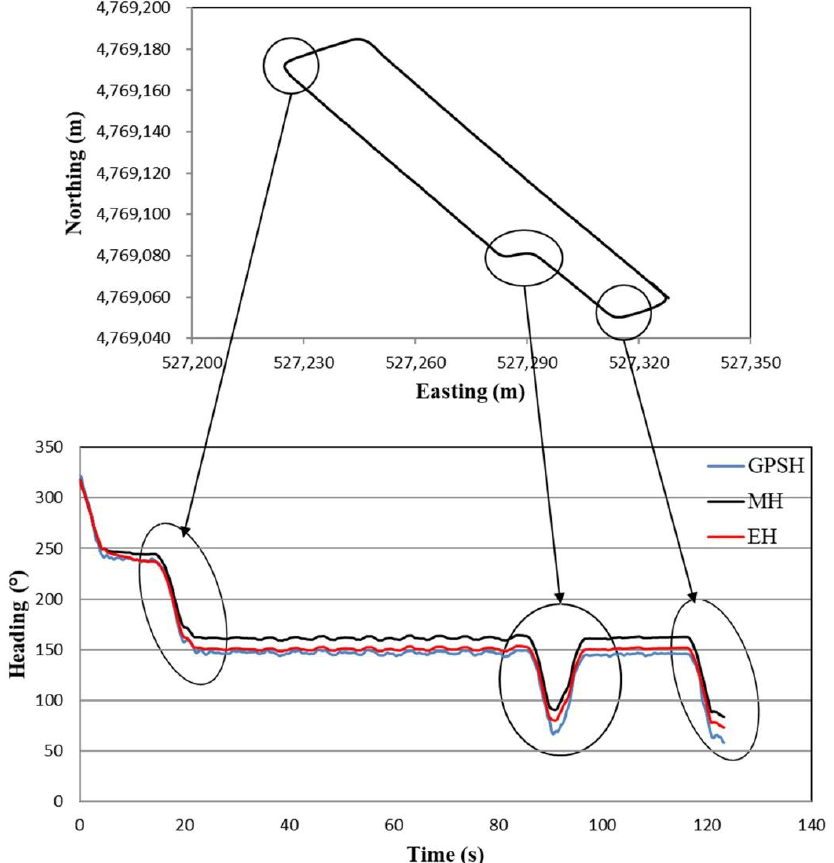
Figure 8. Outlook of a concave polygon field (top figure) and, measured and estimated heading (bottom figure) for the concave polygon field.